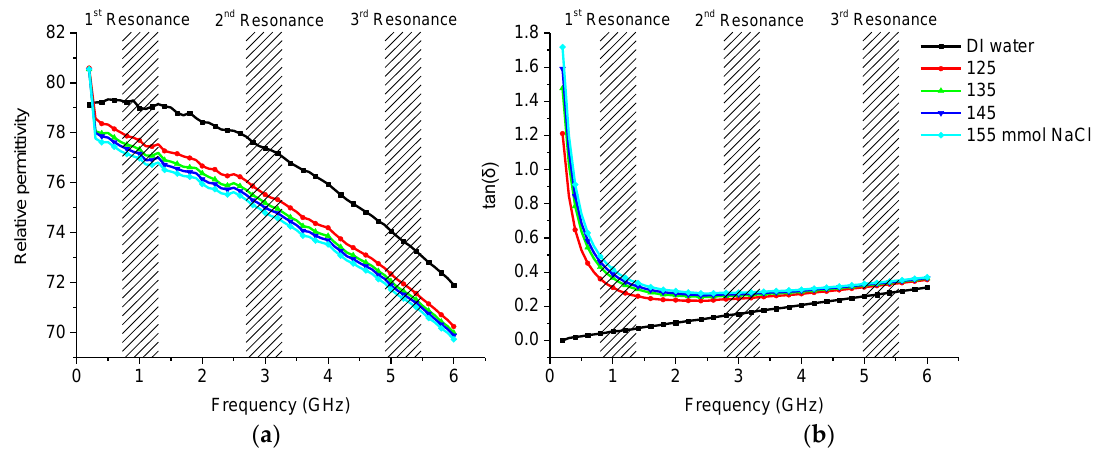
Figure 12. Permittivity and losses of saline water measured with DAK system: ( a ) Permittivity; ( b ) Loss tangent.